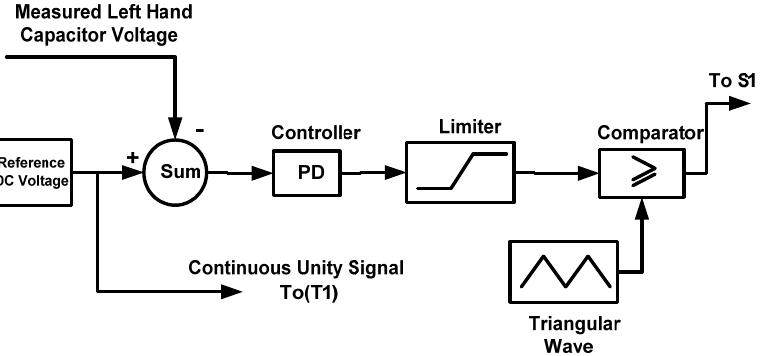
Figure 7. The Adopted Control Technique to Obtain +ve DC Voltage at the Output of the Adopted Converter.